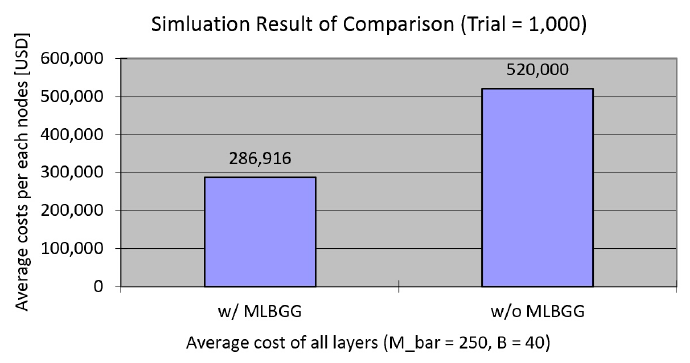
Figure 7. Performance comparison